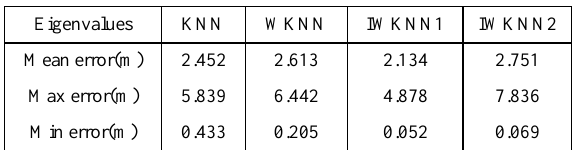
Table 1 . Positioning results when using OPPO smartphone.